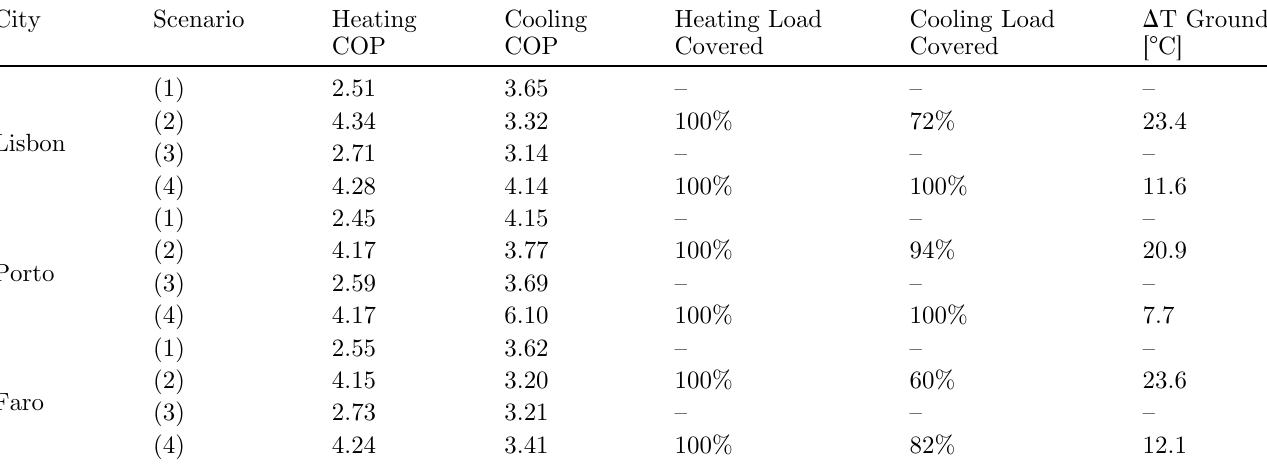
Table 2. COP for each scenario, fraction of thermal load covered by GSHP, and increase in ground temperature after 50 years of GSHP